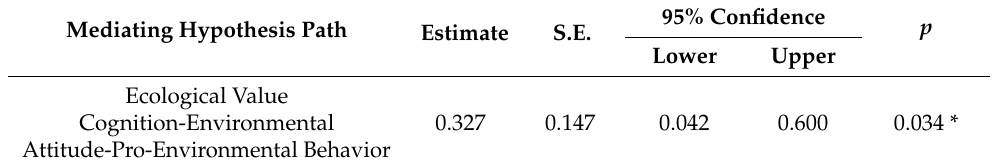
Table 11. Bootstrap for mediating effect test.